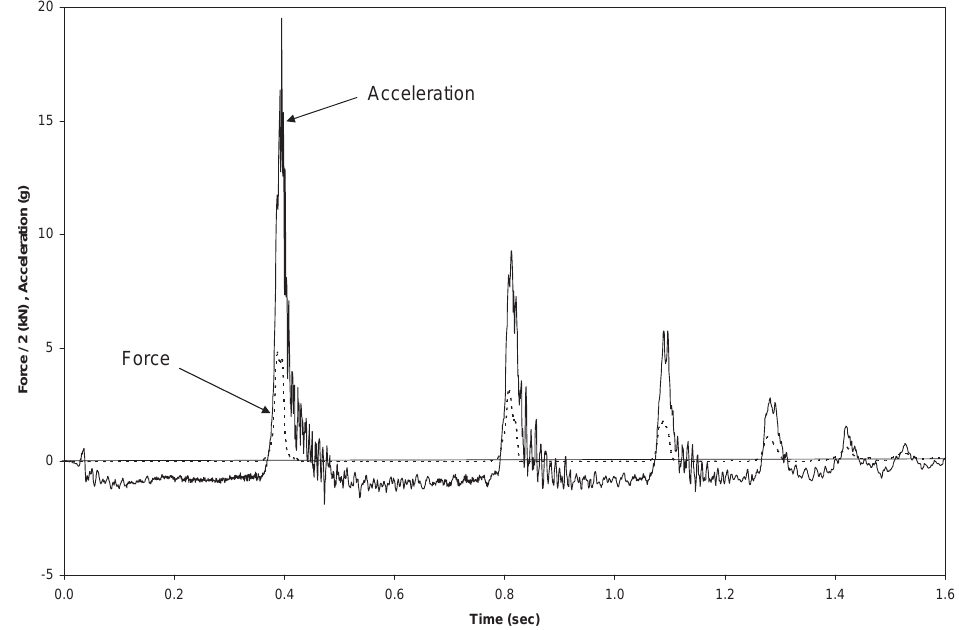
Fig. 3. Dynamic test of Amsteel II rope showing force and acceleration for six taut phases; weight = 289 N, height = 51 cm.